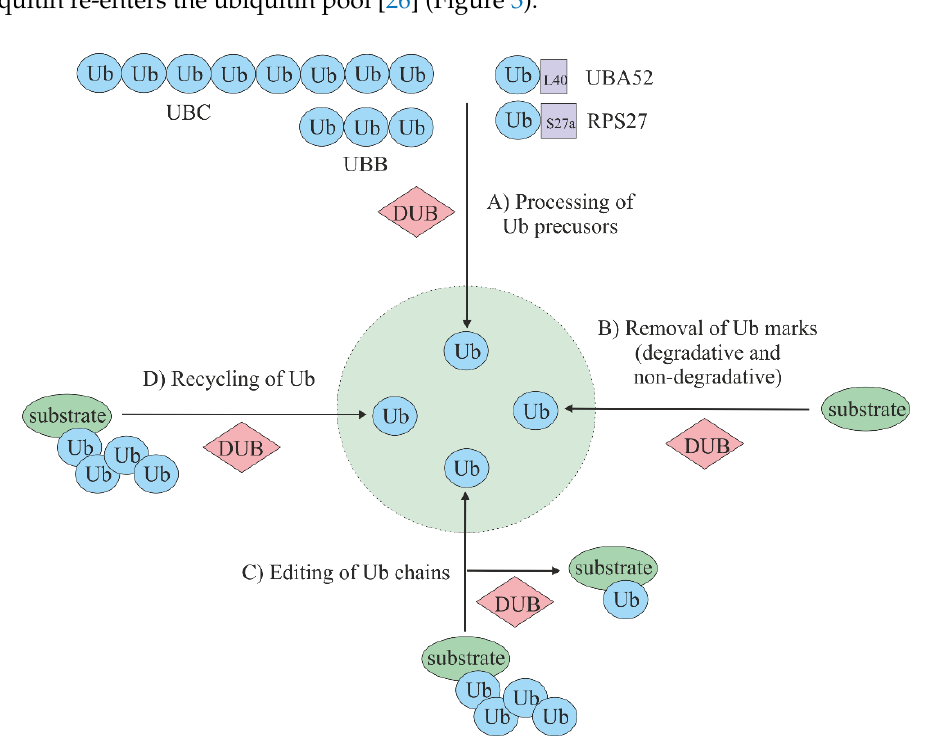
Figure 3. Cellular role of deubiquitinating enzymes (DUBs). ( A ) Processing of ubiquitin precursors. Ubiquitin is encoded by four genes: UBA52, RPS27, UBB, and UBC. In the case of UBA52 and RPS27, ubiquitin is produced as a precursor, where a single ubiquitin is attached to ribosomal proteins L40 or S27a. The UBC and UBB genes express precursors comprised of 3–10 single ubiquitins attached “head to tail”. The production of free ubiquitin out of the precursor forms is one of the main roles of DUBs. ( B ) Removal of degradative or nondegradative marks from protein substrates, therefore rescuing substrates from degradation or modulating ubiquitylation signaling. ( C ) Editing of ubiquitin chains by changing one type of ubiquitin signal to another (e.g., transformation of polyubiquitin tag to monoubiquitin tag). ( D ) Recycling that ensures ubiquitin re-enters the ubiquitin pool by preventing ubiquitin degradation in the proteasome or lysosome together with its substrate.